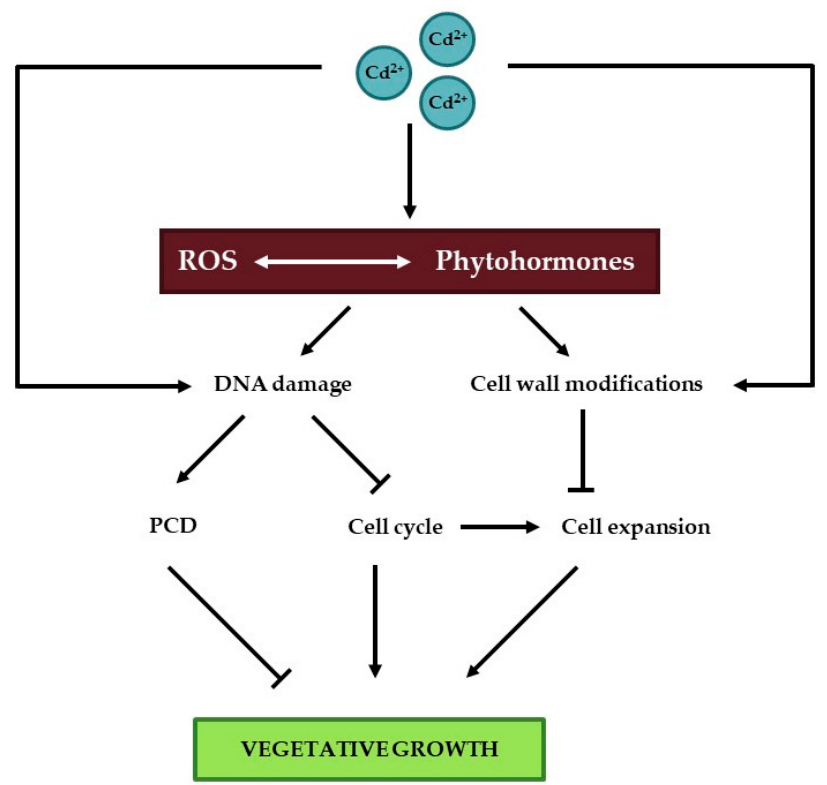
Figure 2. Schematic overview of important players a ff ecting vegetative plant growth upon Cd exposure. Cadmium exposure is well known to a ff ect concentrations of reactive oxygen species (ROS) and phytohormones, which are closely intertwined. Cadmium induces DNA damage, thereby activating the DNA damage response, which can either induce programmed cell death (PCD) or a ff ect cell cycle progression, depending on the extent of DNA damage. In addition, Cd exposure induces cell wall modifications as a strategy to reduce Cd entry into cells. This in turn limits cell expansion, which is intertwined with the cell cycle and specifically endoreduplication. Cadmium-induced DNA damage and cell wall modifications could either result from its e ff ects on ROS and phytohormone levels or arise through an alternative pathway. Together, Cd-induced PCD, cell cycle alterations and inhibition of cell expansion contribute to its negative e ff ect on vegetative growth. One-way arrows indicate stimulating e ff ects, whereas T-shaped arrows represent an inhibitory e ff ect. Two-way arrows signify an interaction.